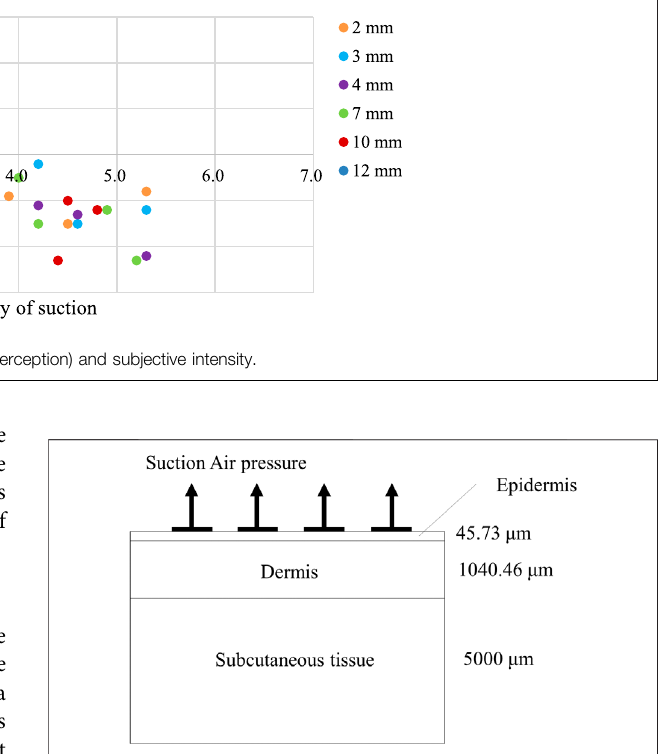
Figure 9 . The results show that low-intensity suction is likely to suction, irrespective of the shape of the suction unit.